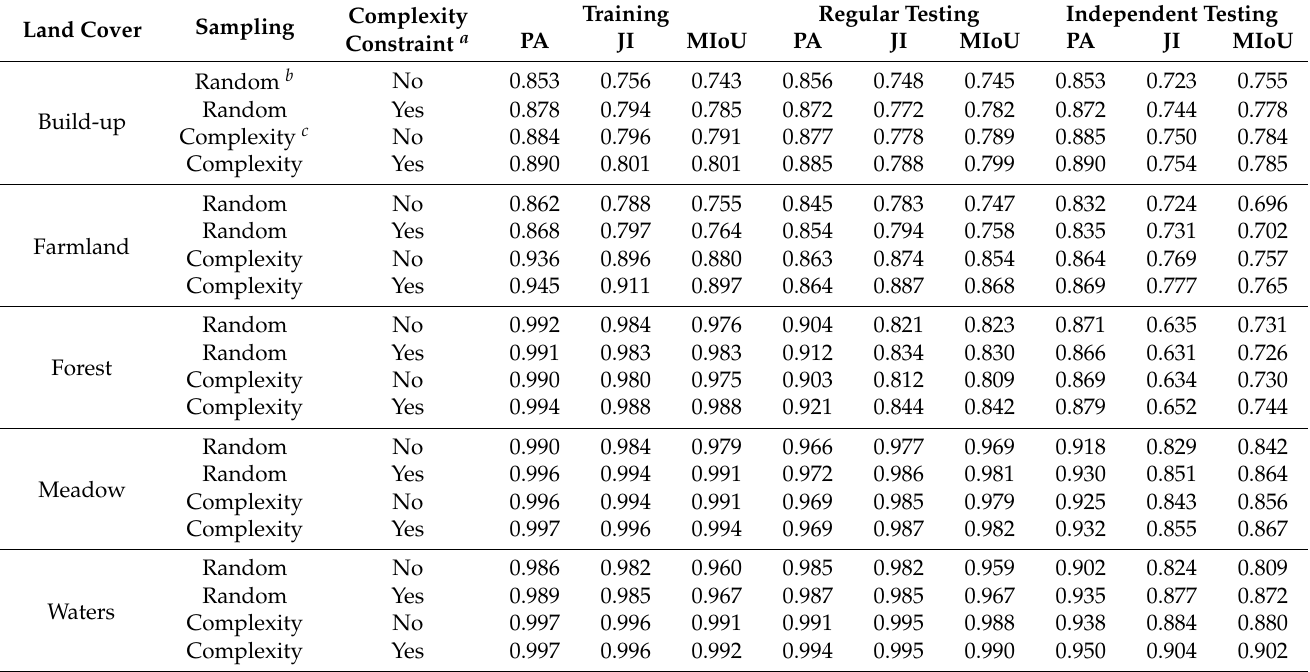
Table 3. Performances of the UNet using different sampling methods and complexity constraint.